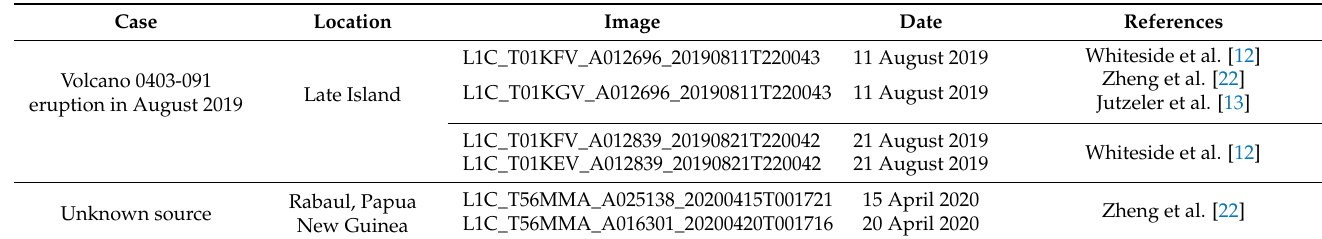
Figure 9. Application of the SFBE algorithm to MSI images used in previous studies. ( a ) Data used in Whiteside et al. [12], Jutzeler et al. [13], and Zheng et al. [22] near Late Island from Tonga volcano eruption on 11 August 2019; ( b ) data used in Whiteside et al. [12] near Late Island from Tonga volcano eruption on 21 August 2019. Data used in Zheng et al. [22] from Rabaul, Papua New Guinea on ( c ) 15 April 2020, and ( d ) 20 April 2020; ( e – h ) the extracted pumice rafts by SFBE algorithm proposed in this study from images listed in panels a to d, respectively. The white color areas indicate pumice rafts, and the black areas indicate others in panels ( e – h ). Insets in panels a and e show the zoomed in image and extraction results in the red rectangular area, respectively. Table 3. MSI images used for comparison and